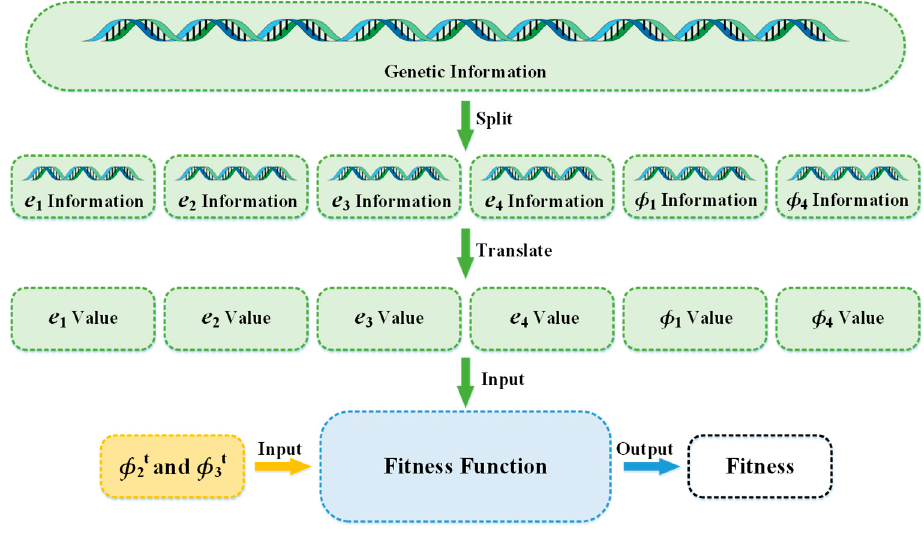
Figure 5. Fitness-solving process.